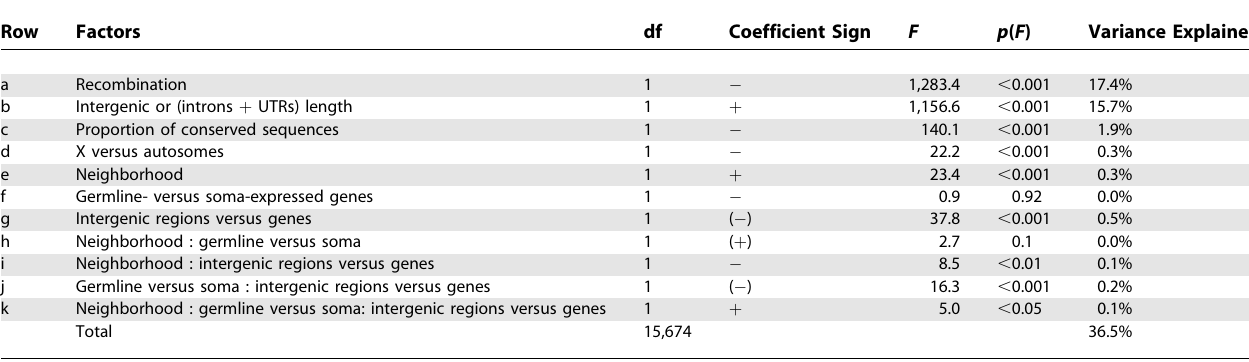
Table 1. Factors Affecting the Number of TE Insertions in Genes and Intergenic Regions (GLM Analysis) Row Factors